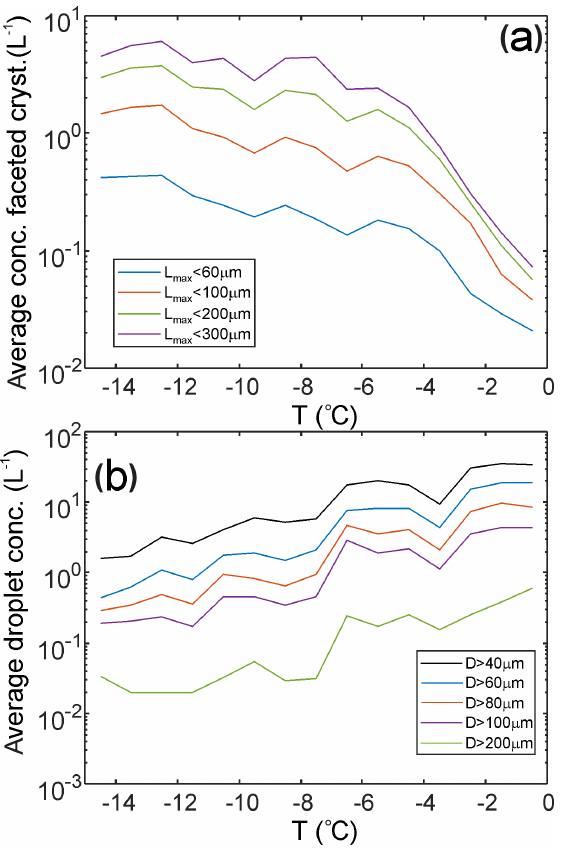
Figure 11. Average concentration of small faceted ice crystals (a) and drops (b) estimated from CPI measurements. The concentration was averaged over the entire flight length sampled during 13 flights in 10 tropical MCSs. The concentration was normalized on the sam- pling distance in each 1 ◦ C temperature interval. Total number of 1s average samples is 8 . 4 × 10 4 ; total in-cloud length is